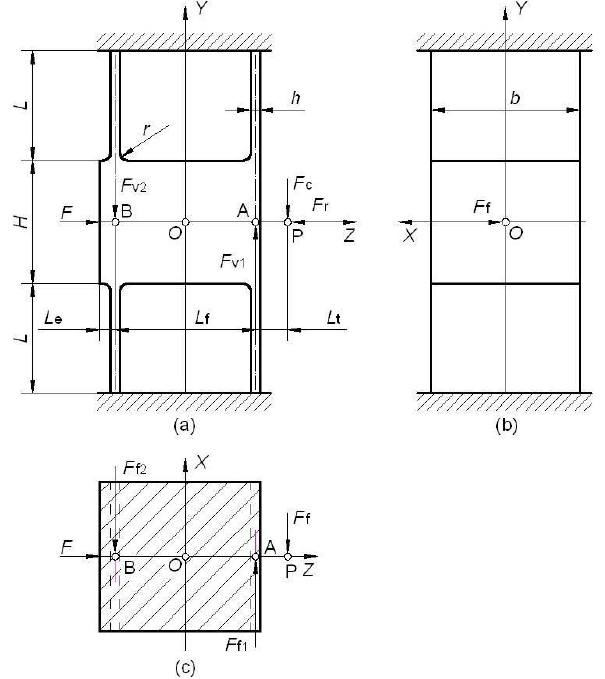
Figure 3. Three orthographic projections of the CM: (a) front view; (b) side view; (c) top view. The reference system (the origin O and the axes X, Y, and Z), the critical dimensions ( L , H , b , h , L e , L f , L t ), the force components (the actuating force F , the cutting force F c , the feed force F f , and the thrust force F r at the tool tip P; the reaction force F v1 , F f1 at the centre point A of the front set of beams, the reaction force F v2 , F f2 at the centre point B of the rear set of beams) are also displayed.